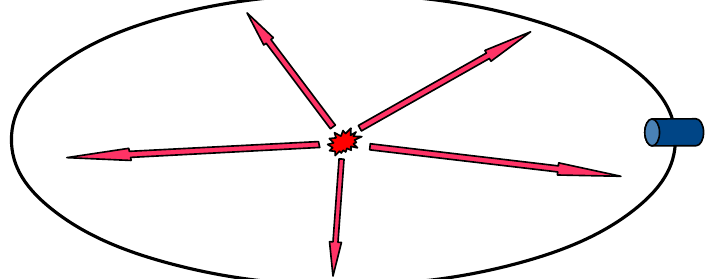
Figure 6 . Holographic null energy condition (HNEC): a holographic CFT is prepared in an excited state j (cid:9) i by inserting an operator O near the origin and an instrument which is shown in blue, measures the holographic null energy E r far away from the